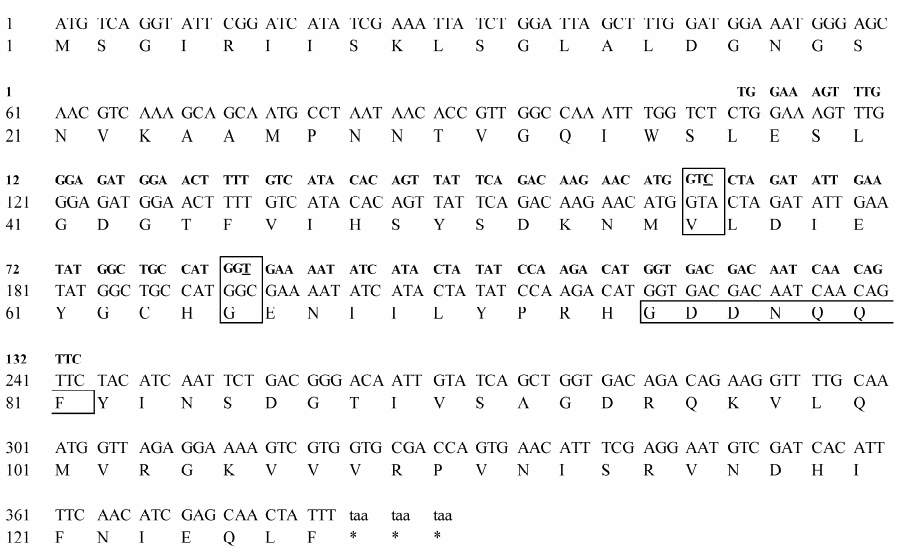
Figure 1. Amino acid sequence of the LdRBLk protein ( bottom line ) aligned with the nucleotide sequence of the LdRBLk gene from NCBI TSA data ( middle line ) and the nucleotide sequence of the PCR product LdRBLk obtained in this study by qPCR ( top line ). The positions of point nucleotide substitutions in the LdRBLk gene region obtained by qPCR are underlined and boxed. The box shows the amino acid residues of the hydrophilic center of the LdRBLk peptide.